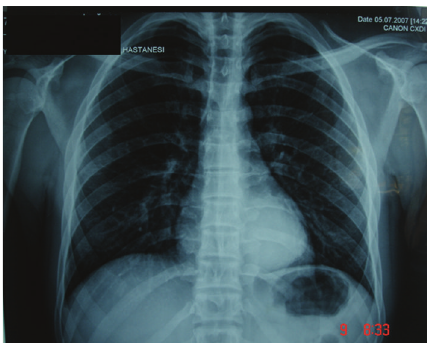
Figure 1: PA chest X-ray revealed a well-demarcated 6 cm periph- eral opacity in the left lower lobe nearly by the diaphragm.